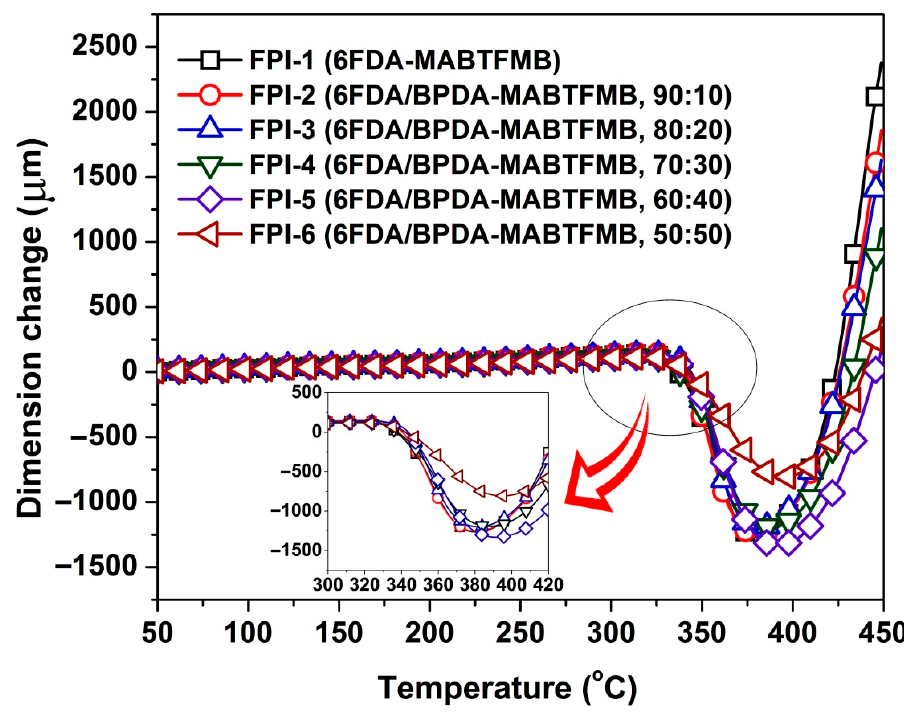
Figure 9. TMA plots of FPI films.